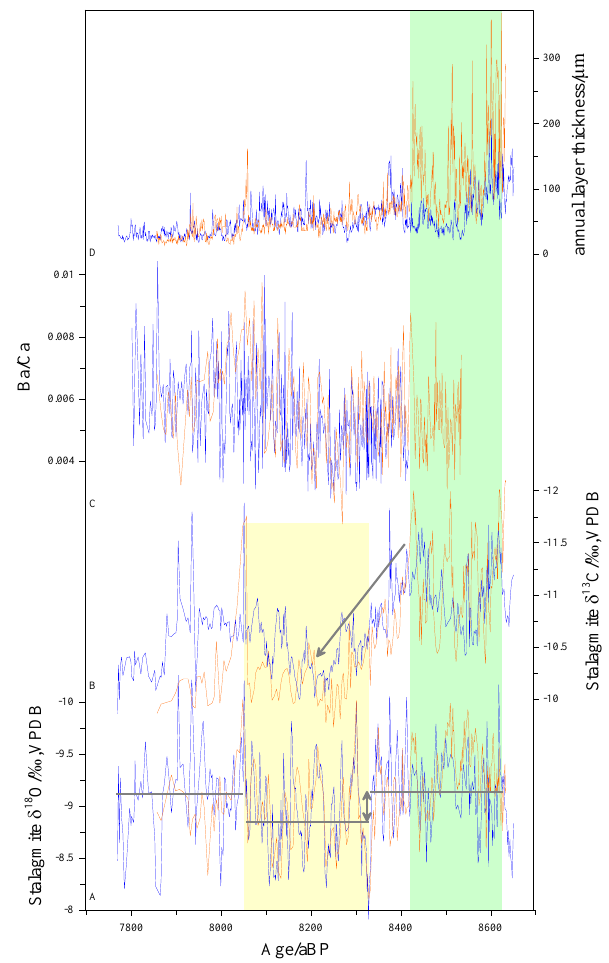
Fig. 4. Comparison of multi-proxy records between two stalagmites (NH33-blue curves and NH6-orange curves). (A) δ 18 O records, the gray lines designate average values of δ 18 O in 3 phases; (B) δ 13 C records, the gray arrow illustrates the same trend between two δ 13 C records; (C) Ba/Ca ratio records; (D) annual layer thickness